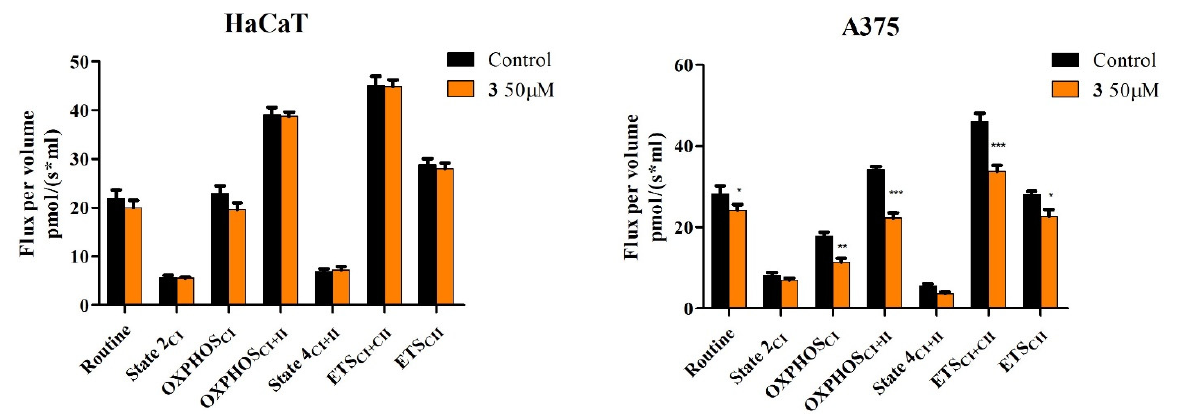
Figure 10. Respiration of permeabilized immortalized human keratinocytes (HaCaT) and human melanoma cells (A375) following 24 h of stimulation with 50 μ M 3 . Data represent the mean ± SD of five individual experiments. Values with p < 0.05 were considered to have statistically significant differences (* p < 0.05, ** p < 0.01, and *** p < 0.01). The respiratory parameters displayed represent the following: Routine—respiration of cells suspended in a substrate-free media, supported by endogenous ADP; State 2 CI —mitochondrial respiration in basal conditions driven by CI, OXPHOS CI —active respiration dependent on CI substrates and exogenous ADP; OXPHOS CI+II — maximal active respiration driven by both CI and CII; State 4 CI+II —basal respiration dependent on both CI and CII; ETS CI+II —maximal respiratory capacity of the electron transport system in the fully noncoupled state; ETS CII —electron transport system maximal capacity dependent only on CII.